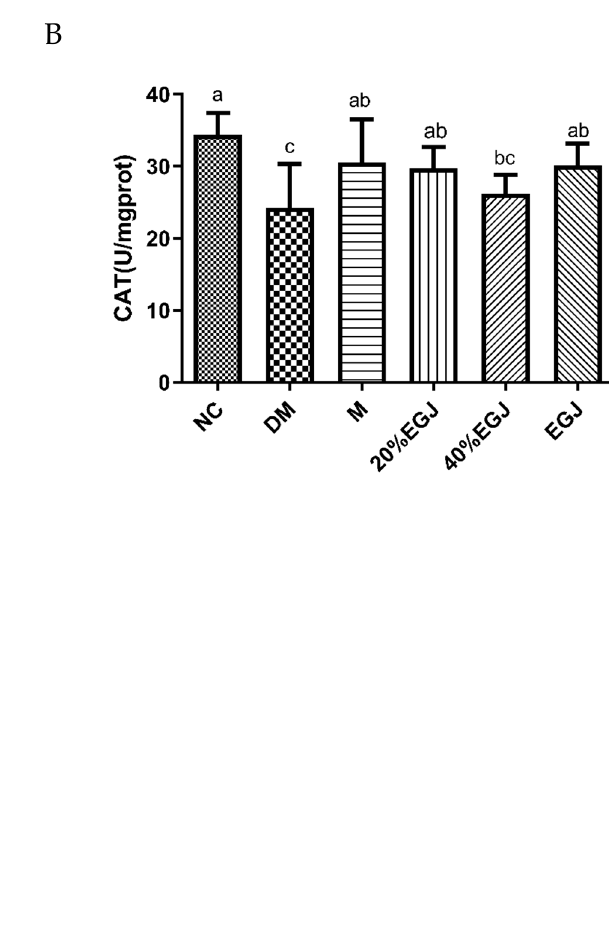
Figure 12. ( A – F ) stands for the TC, TG, HDL-C, LDL-C, AI, and CVRI of the mice in each group, respectively. Note: the data were expressed as the mean ± the SD ( n = 9) and the different letters marked above the bars showed the significant differences ( p < 0.05). 3.4.5. Effects of the Crude EGJ and Its 20% and 40% Fractions on Hepatic MDA, CAT, and SOD As shown in Figure 13A, the MDA levels in the M and 20% EGJ groups were reduced. However, there was no significant difference between the MDA levels in the 40% EGJ group and the model group, indicating that the 40% EGJ (crocin I) group did not show an ability to eliminate the free radicals in the DM mice, whereas the 20% EGJ (geniposide) group could scavenge the free radicals in the DM mice. Then, we further measured the level of CAT. As shown in Figure 13B, there was no significant difference between the 40% EGJ group and the DM group. The level of CAT in the other groups could not reach the level in the NC group but was higher than the DM group, indicating that metformin and the 20% EGJ could improve the level of CAT in the T2DM mice. Consequently, met- formin and the 20% EGJ (geniposide) could accelerate the decomposition of hydrogen ox- ide to produce oxygen and water in the body and reduce the damage to the body. SOD could increase the active substances in the body and reduce the harmful substances pro- duced by the metabolism. The level of SOD was similar to the level of MDA and CAT. The